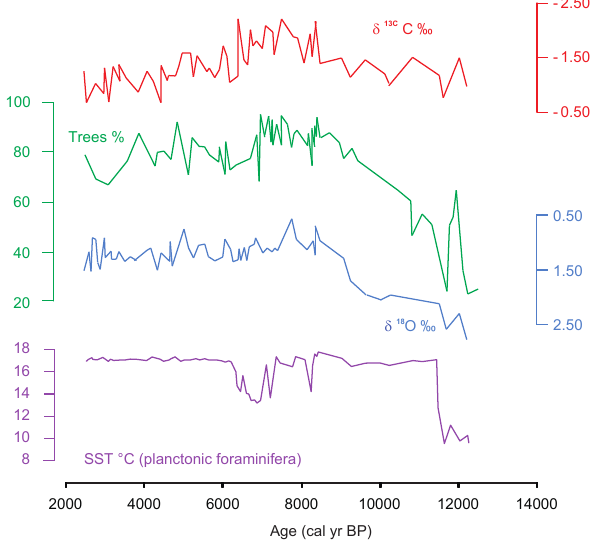
Fig. 6. Comparison of the total tree percentage curve (green) (this paper) and the δ 18 O (blue), δ 13 C (red) and SST ( ◦ C, purple) records from the MD 90-917 core (Siani et al., 2013). All curves are presented in cal yr